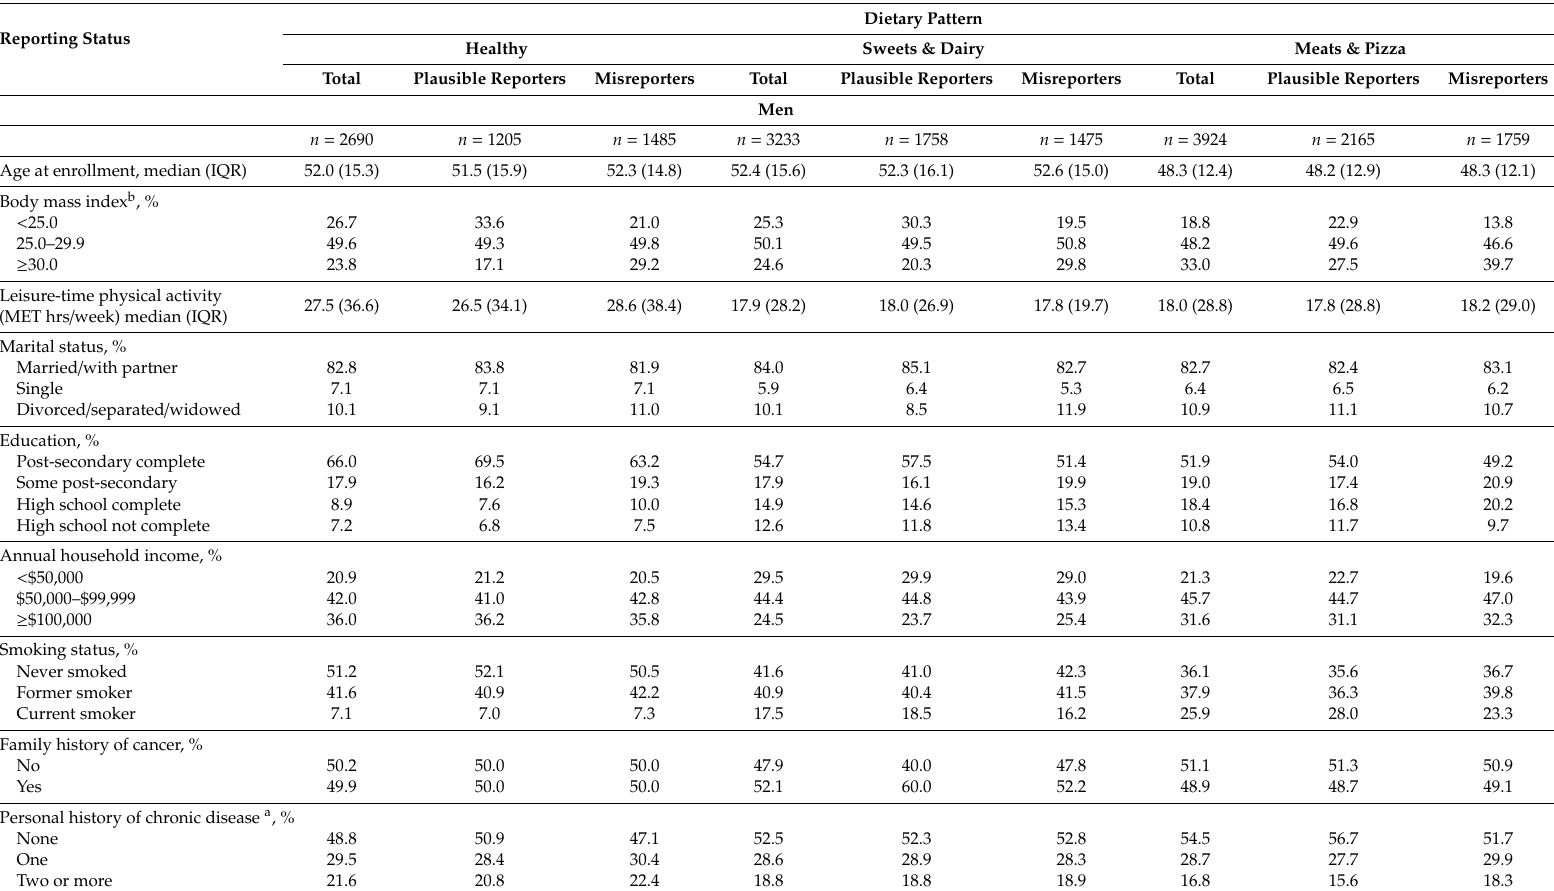
Table 2. Baseline sociodemographic characteristics by EI reporting status and dietary